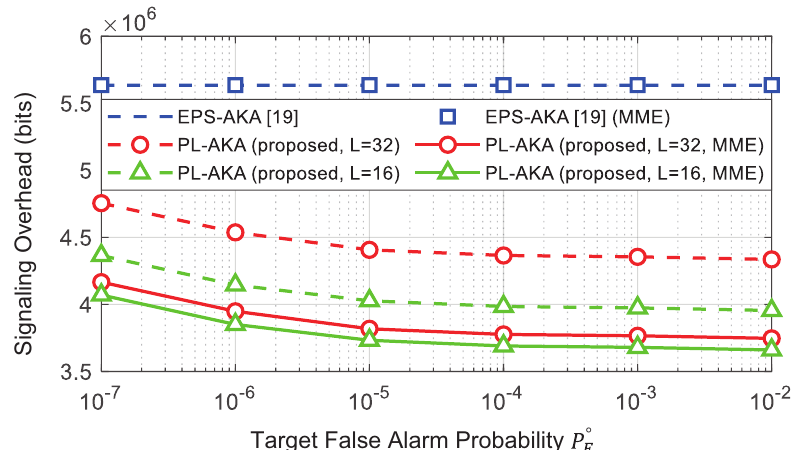
Figure 9. Signaling overheads of PL-AKA and EPS-AKA over various target false alarm probabilities (experiment